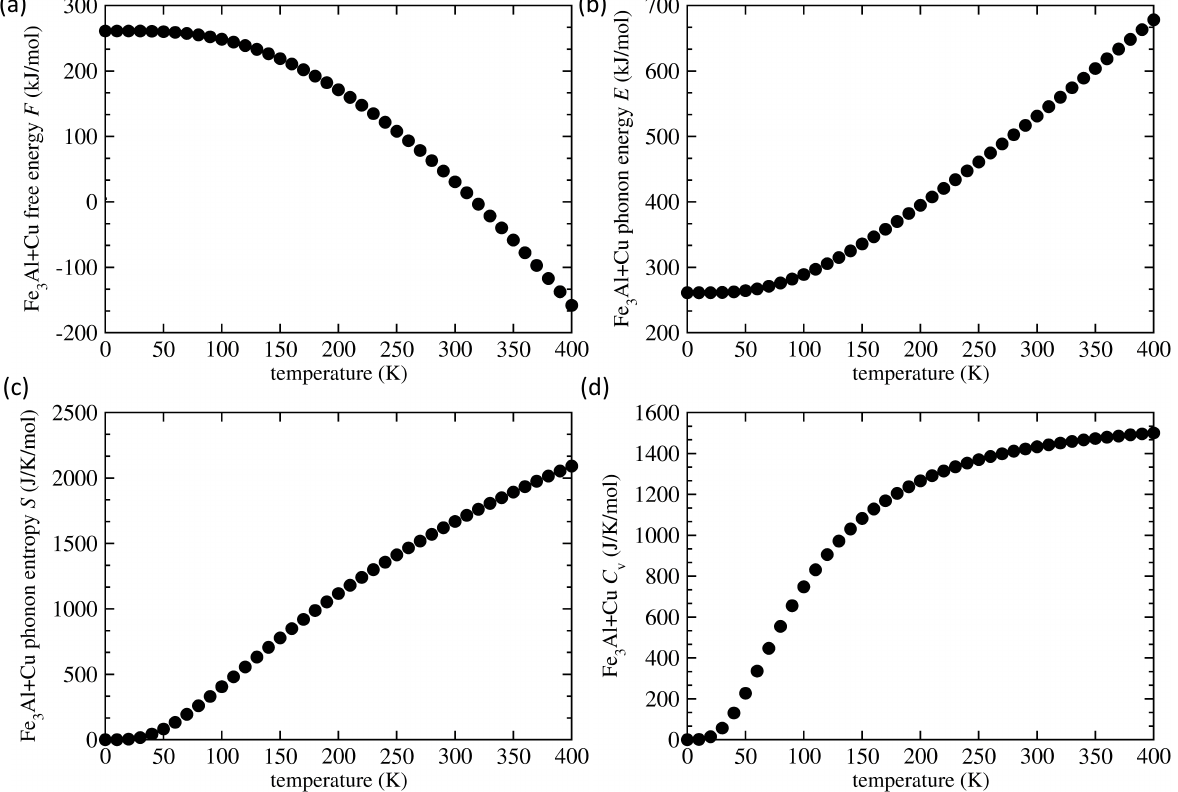
Figure 4. Calculated Helmholtz free energy F ( a ) and the harmonic phonon energy E ( b ) of defect-free Fe 3 Al containing the Cu atoms together with derived vibrational entropy S ( c ) and constant-volume heat capacity C v ( d ), respectively. The elementary entity for defining one mol is the 64-atom supercell, i.e., we talk about one mole of 64-atom